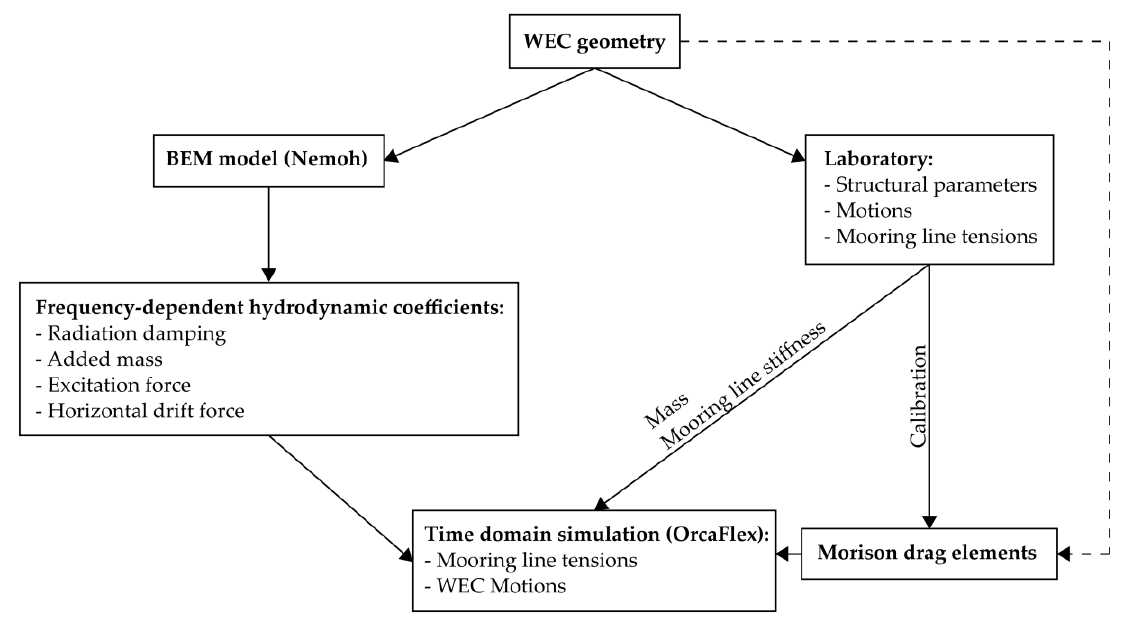
Figure 4. Flow-chart of the numerical model.